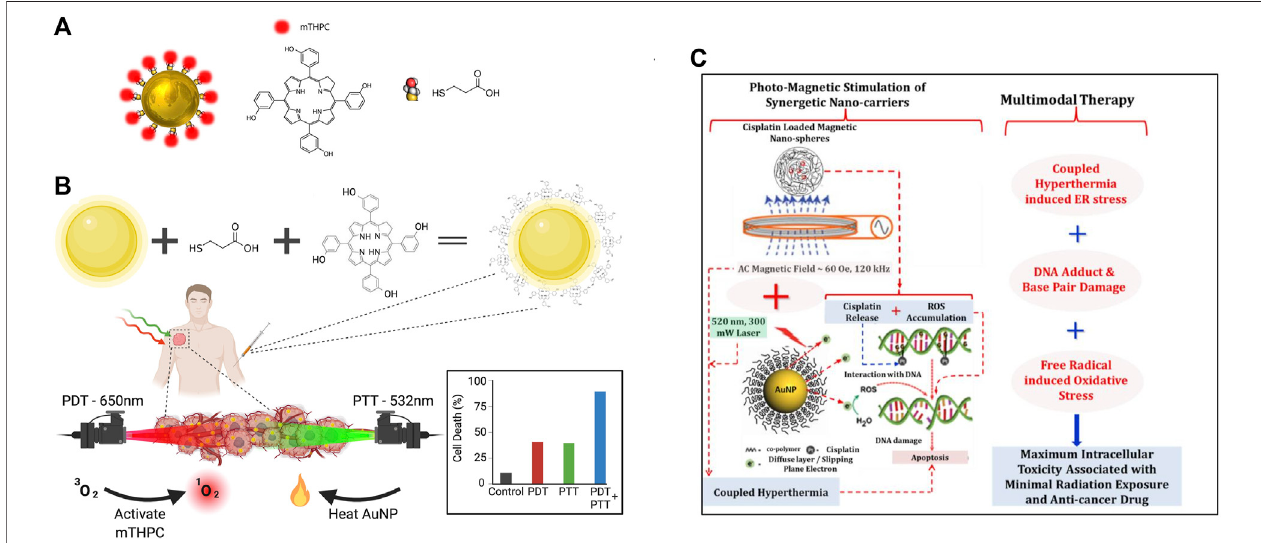
FIGURE 5 | Nanotechnology for phototherapy in NB. (A) The AuNP-mTHPC complex is illustrated with the chemical structure of mTHPC in the conjugate and the linker 3-mercaptopropionic acid. Reproduced with permission from: Elina Haimov, Hana Weitman, Shlomi Polani, Hadas Schori, David Zitoun, and Orit She fi . meso- tetrahydroxyphenylchlorin-conjugated gold nanoparticles as a tool to Improve Photodynamic Therapy. ACS applied materials & interfaces, 2018, 10(3): 2319 – 2327 (Haimov et al., 2018). Copyright 2018, American Chemical Society. (B) AuNP-mTHPC complexes for PDT and PTT dual therapy. Reproduced from (Varon et al., 2022). (C) Photo-magnetic irradiation mediated multimodal therapeutic strategy of NB cells. Reproduced from (Atluri et al.,